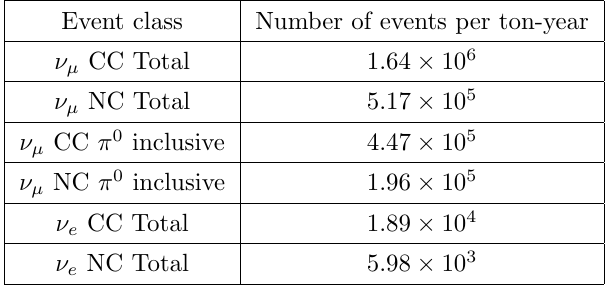
Table 3 . Expected number of neutrino-related events scattering on argon (liquid or gas) assuming 1 t of (cid:12)ducial mass and 1 year of data